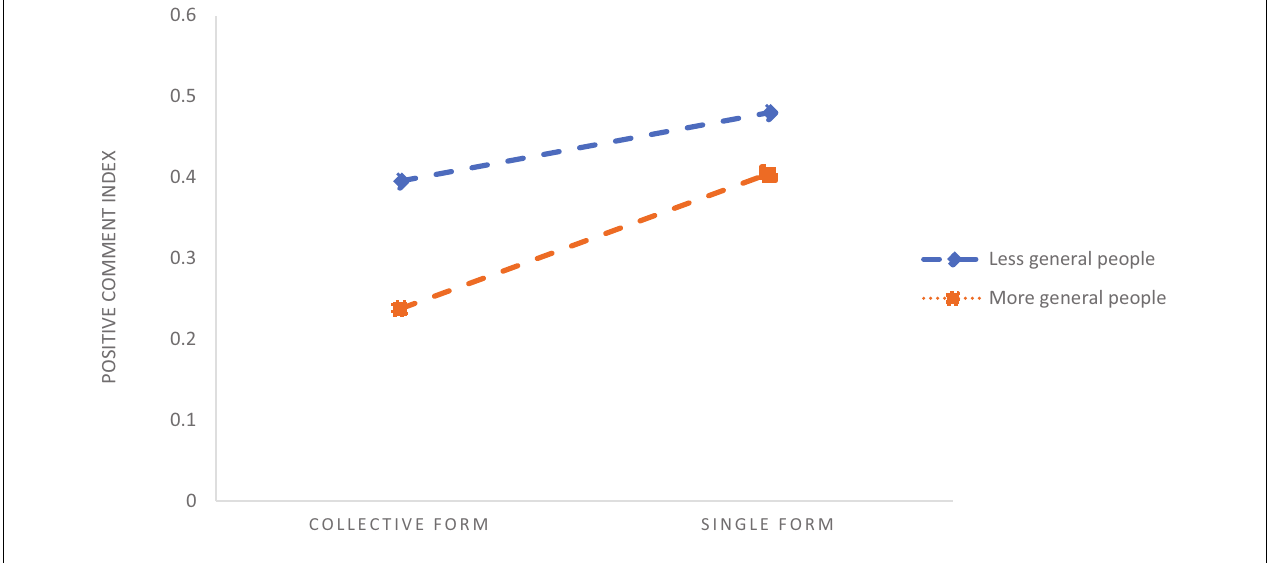
FIGURE 7 | General Publics’ role in moderating the form of